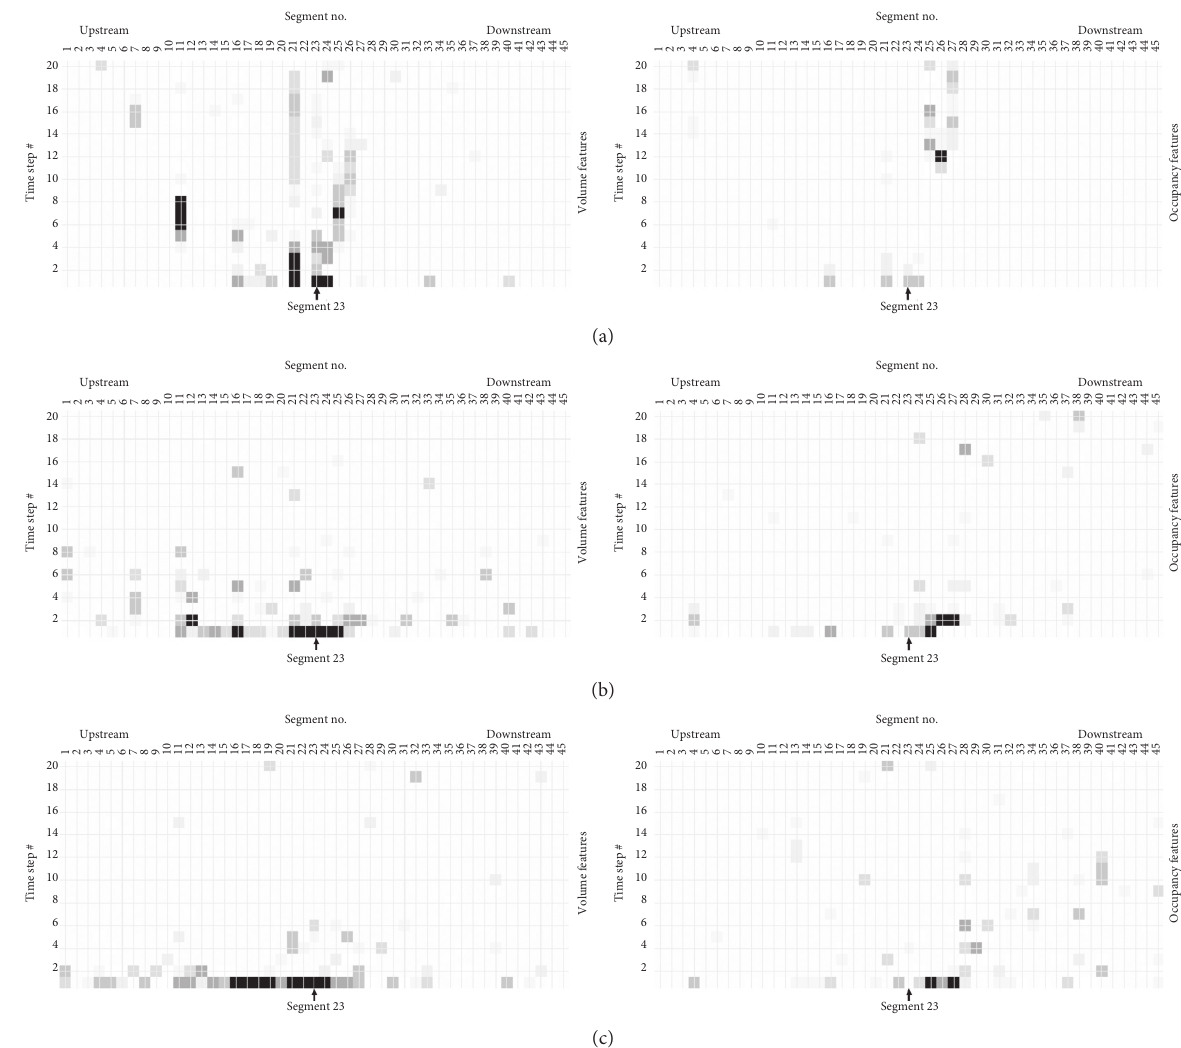
Figure 10: Ranking of attributes in terms of their relative importance to the performance of RF models, for three different input data aggregation levels (segment 23). The plots for the volume features are on the left and those for the occupancy features are on the right. (a) 30sec aggregation level. (b) 5min aggregation level. (c) 15 min aggregation